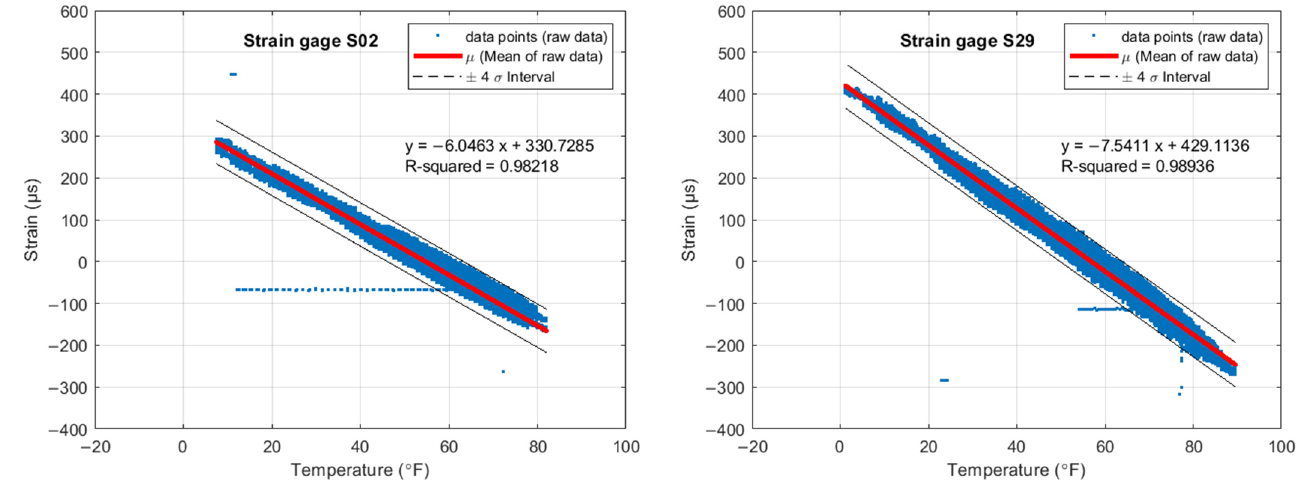
Figure 12. Raw strain vs. raw temperature.